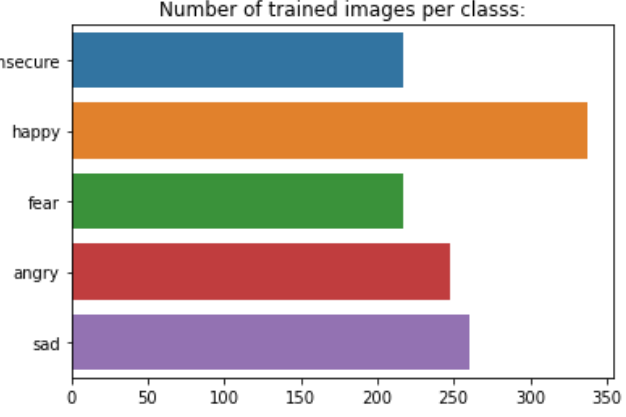
Figure 1. Number of trained images per class.